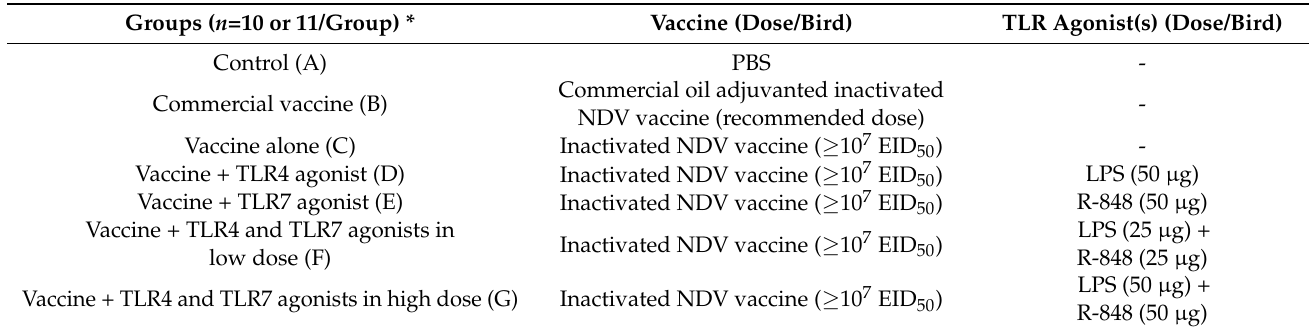
Table 1. Immunization plan followed in the experimental